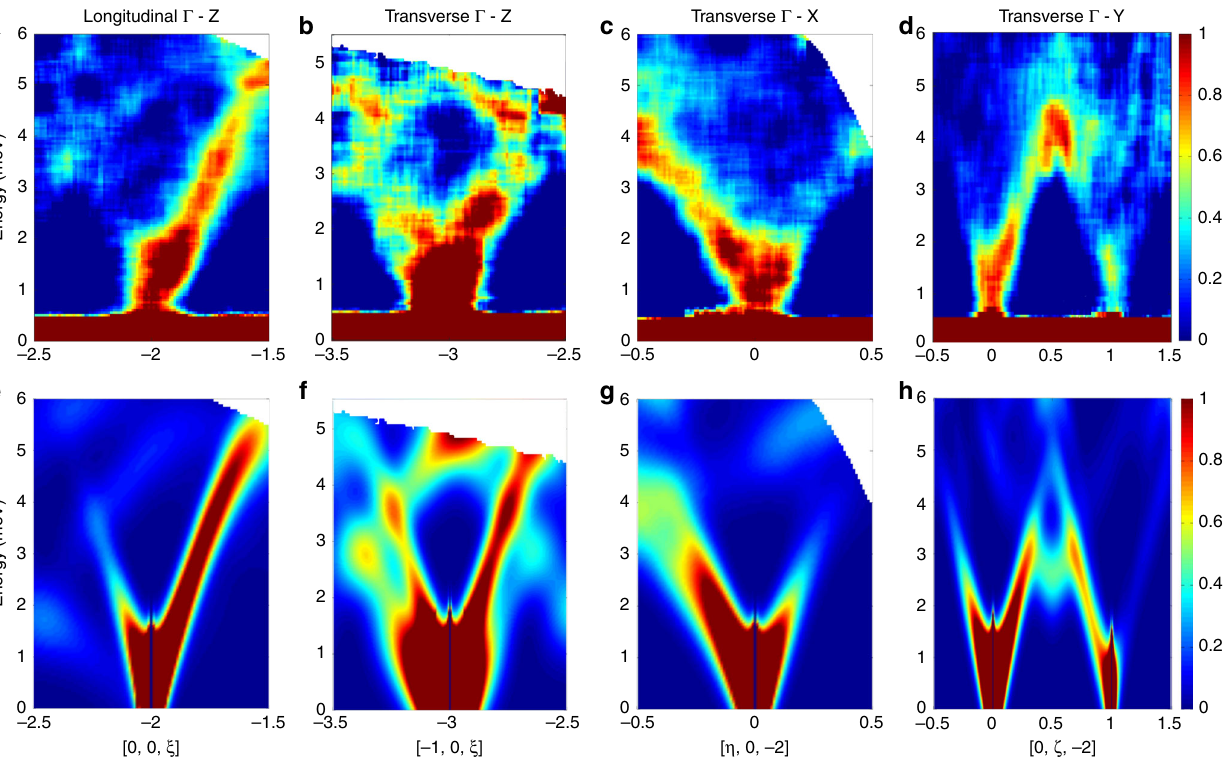
Fig. 3 Phonon dispersions up to 6 meV. In a – d we show representative examples of [VO(acac) 2 ] phonon dispersions measured on LET with E i = 7.3 meV and T = 5 K. This incident energy allowed us to resolve acoustic modes up to 6 meV. Dispersions curves have been obtained integrating over two out of the three components of the neutron scattering vector Q ¼ ½ η ; ζ ; ξ (cid:2) (expressed in terms of reciprocal lattice vector units) around different Bragg peaks. a Shows longitudinal acoustic modes along the symmetry direction Γ – Z around [0, 0, − 2]. b – d Report transverse acoustic modes along three principal symmetry directions: Γ – Z around [ − 1, 0, − 3], Γ – X around [0, 0, − 2] and Γ – Y around [0, 0, − 2] and [0, 1, − 2]. The colour bar reports the intensity normalised for the maximum in each panel. Simulated dispersion curves along the same directions are reported in e – h and were calculated with Eq. (3) (see Methods), with phonon energies and polarisation vectors obtained from